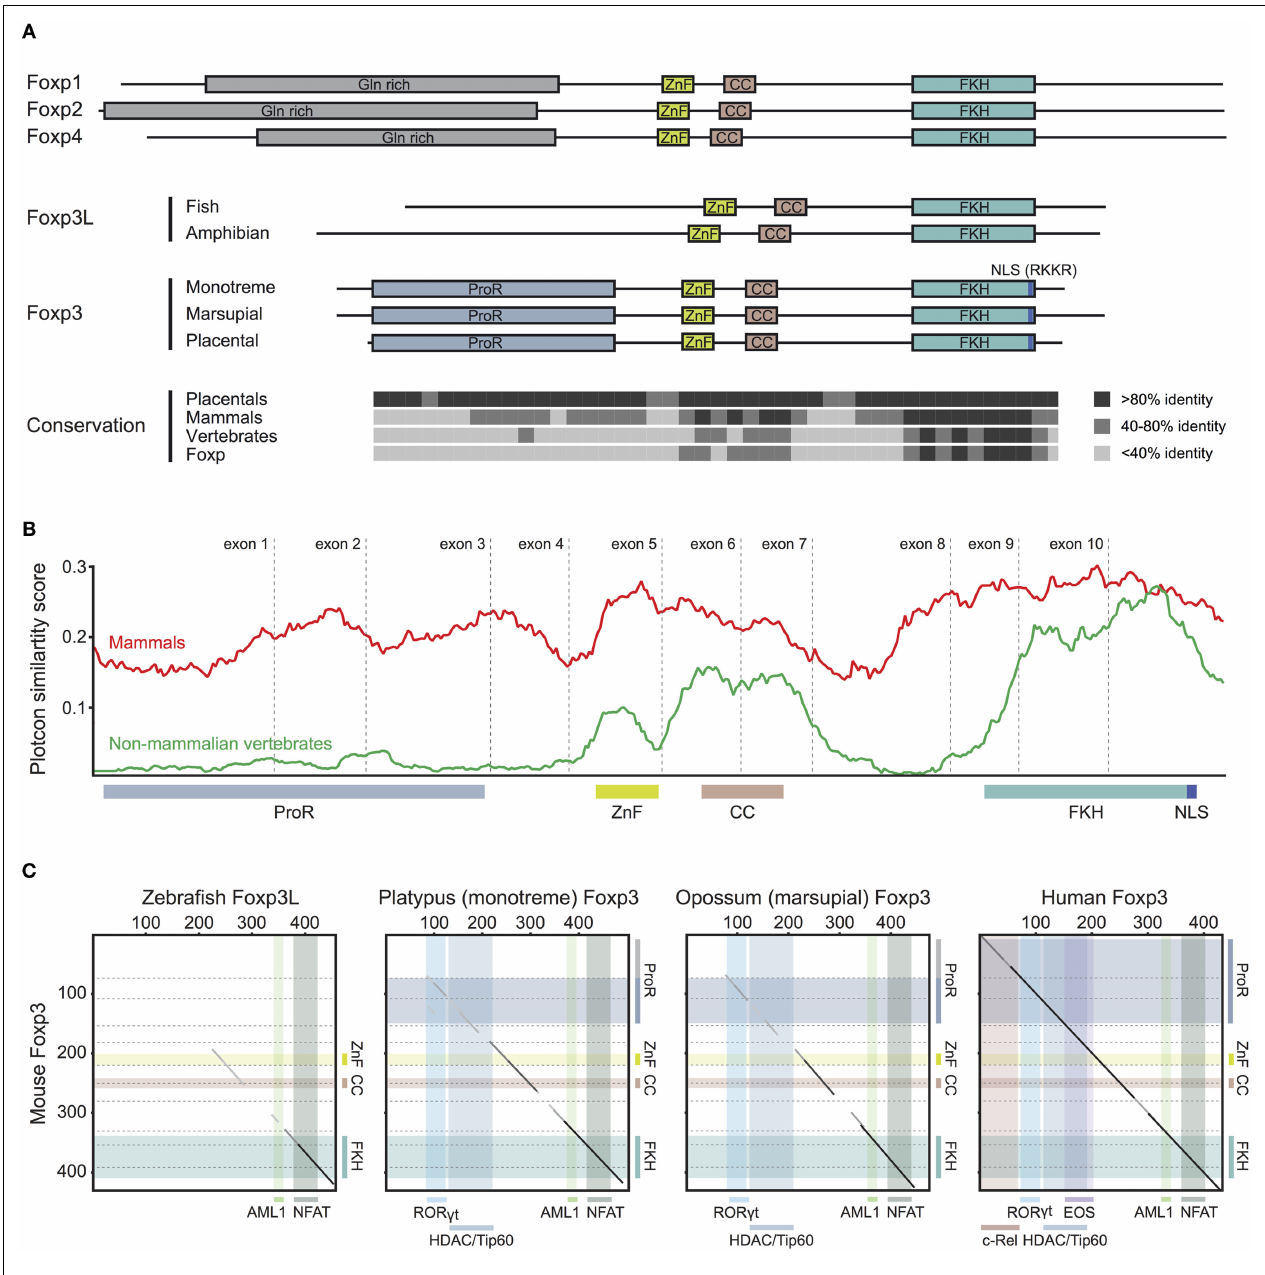
similarity score at individual amino acid positions from multiple sequence alignments of mammalian Foxp3 (red; 10 species) and non-mammalian vertebrate Foxp3L (green; 7 species).The plots were generated using EMBOSS plotcon with a window size of 20 (Rice et al., 2000). (C) Dotblot alignments of Foxp3 proteins with the predicted interaction partners and functional domains overlaid (based on mouse Foxp3; black lines: strongly aligned regions; gray lines: aligned regions; dotted lines: exon boundaries; x -axis color overlays: binding regions of known interaction partners; y -axis color overlays: predicted functional